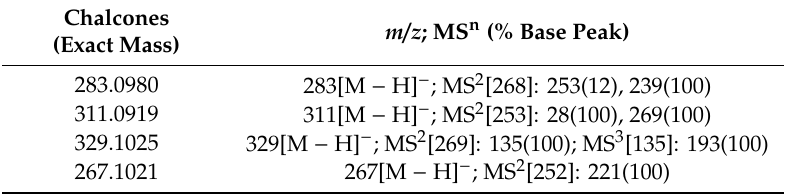
Table 2. MS and HRESIMS data for compounds from Arrabidaea